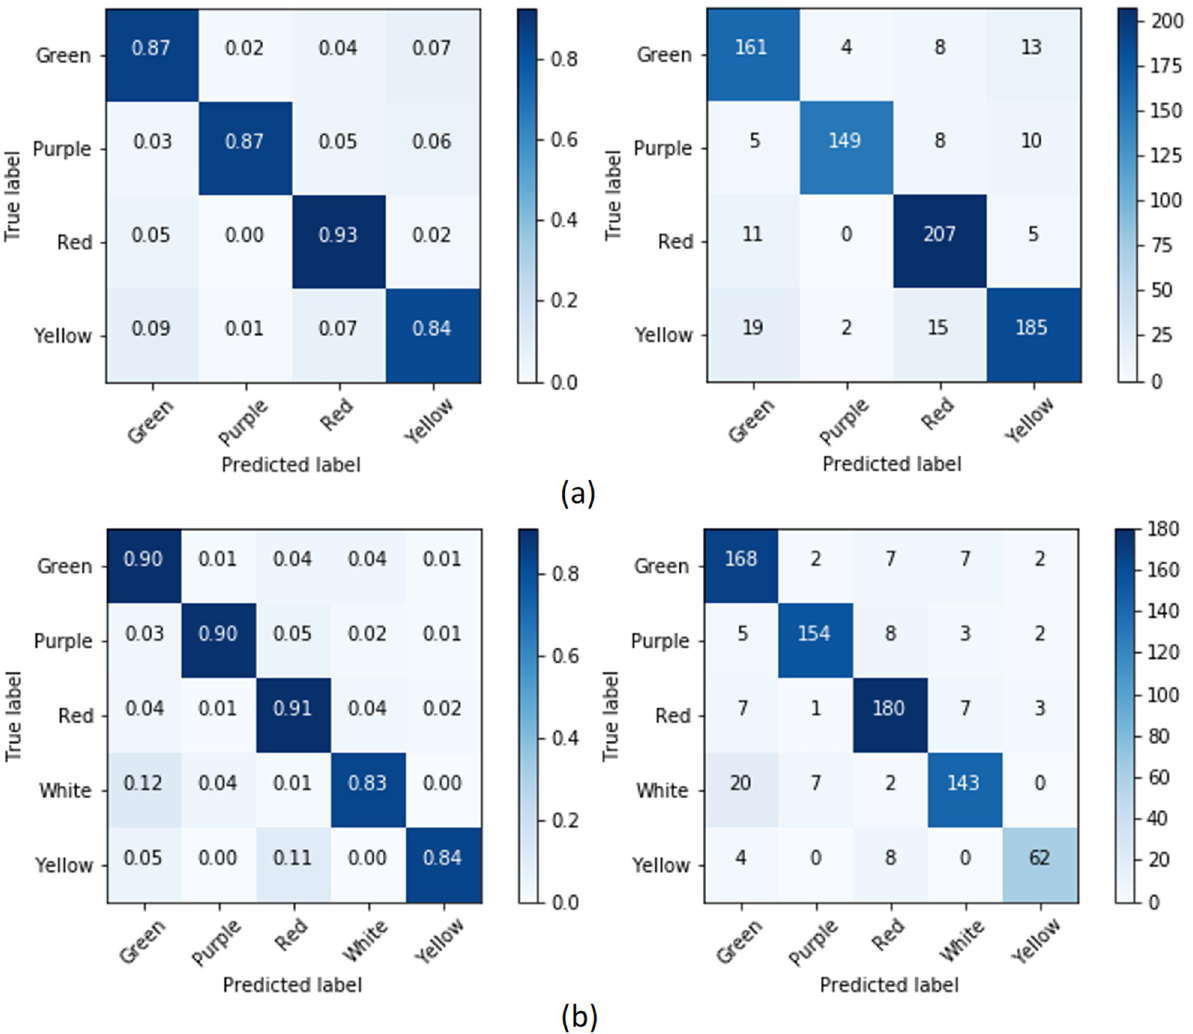
Fig 12. The confusion matrices for primary color: (a) CF1 and (b) CF2 using ensemble